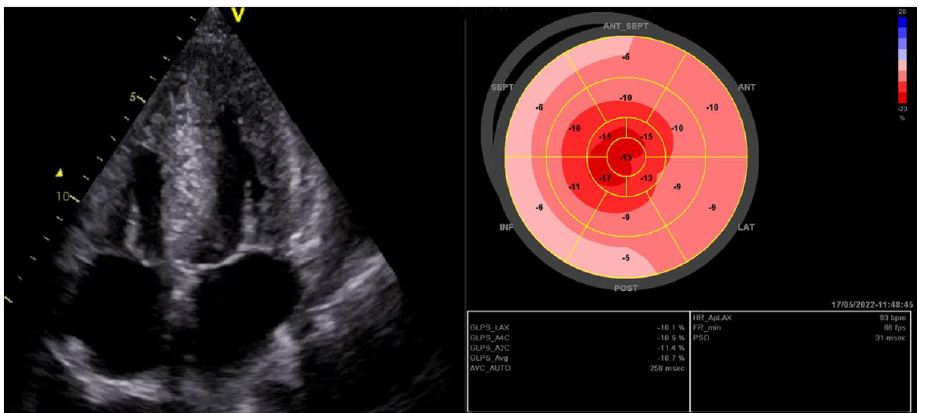
Fig. 3 In the presence of left ventricular hypertrophy, speckle tracking could be an added value, showing a severe impairment of peak systolic longitudinal strain values (with the typical pattern of amyloidosis). LVH indicates left ventricular hypertrophy However, it could be challenging to differentiate between hypertensive heart disease and cardiac amyloidosis because both share an increased left ventricular wall thickness.